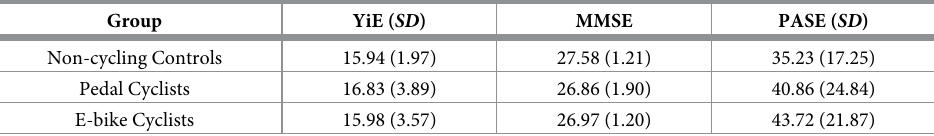
Table 2. Years in education (YiE), mini-mental state examination (MMSE) and physical activity for the elderly results for the non-cycling controls, pedal cyclists and e-bike cyclists before the trial